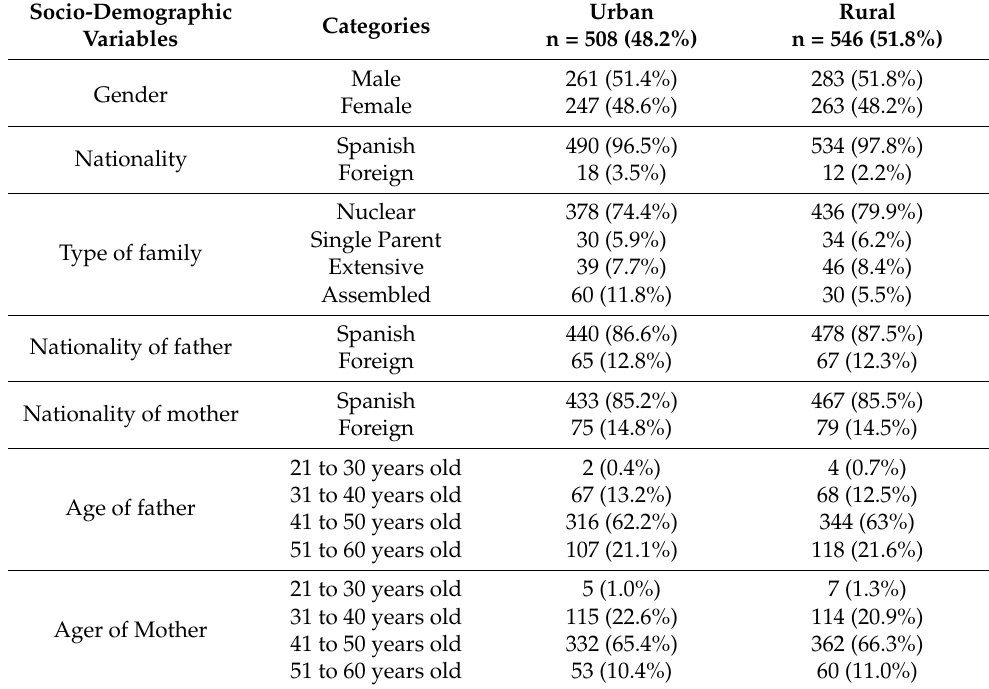
Table 1. Sampling distribution of participants according to geographical